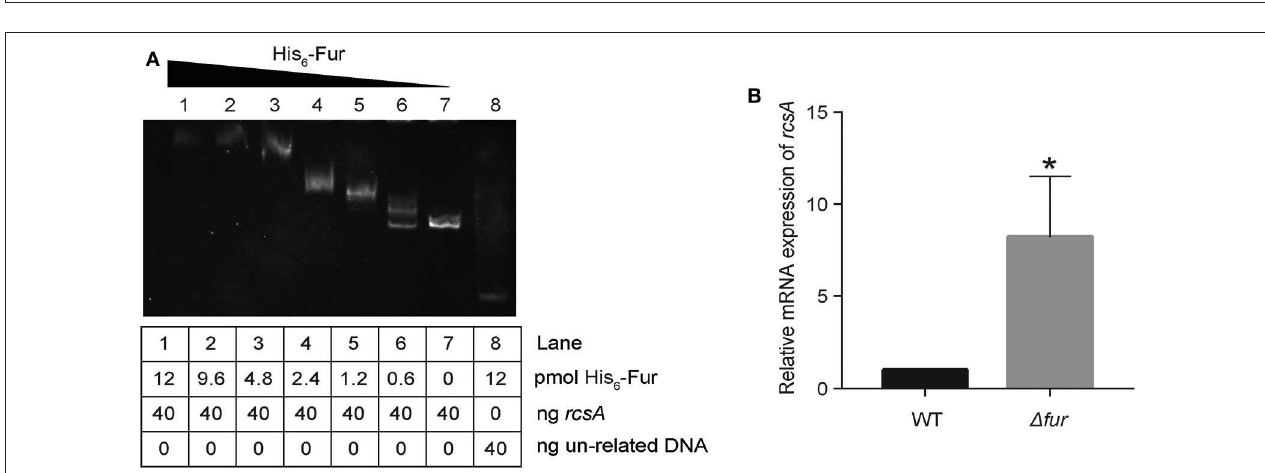
FIGURE 7 | Fur directly represses rcsA . (A) The DNA binding capacity of Fur was evaluated by EMSA with rcsA . (B) Relative mRNA expression of rcsA in WT and Kp: ∆ fur was assayed by RT-qPCR in an iron-rich environment. * P < 0.05, compared with the WT.